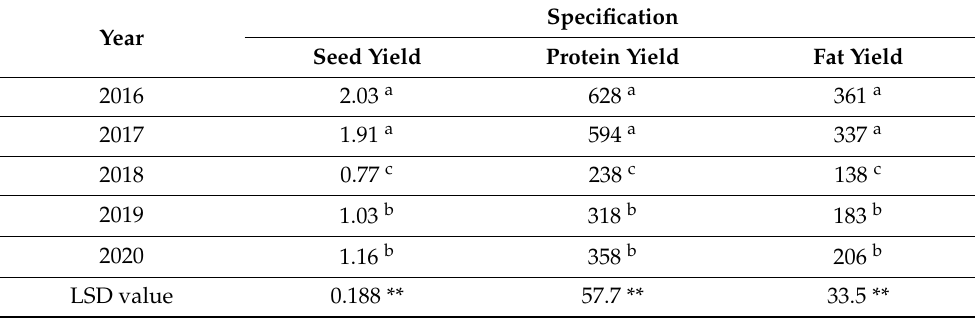
Table 2. The seed yield (t ha − 1 ), protein yield (kg ha − 1 ) and fat yield (kg ha − 1 ) in research